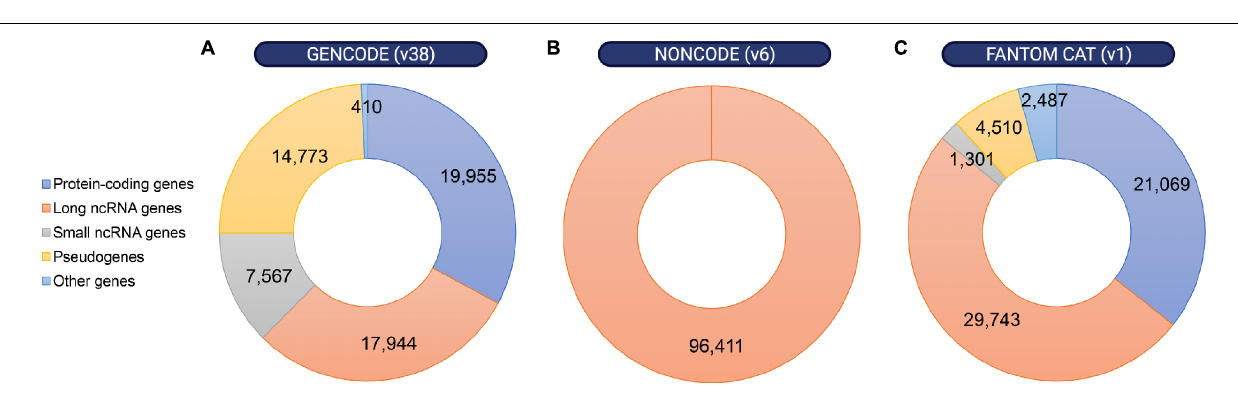
FIGURE 2 | Distribution of annotated loci in the human genome according to different gene map databases. Despite the discrepancies between different annotation methods, non-coding RNA loci are remarkably abundant within the human genome. Number of protein-coding genes, long or small non-coding RNA genes, pseudogenes and other genes were obtained from (A) GENCODE release 38 (https://www.gencodegenes.org/human/stats.html), (B) NON-CODE v6.0 (http://www.noncode.org/analysis.php), and (C) FANTOM CAT v1